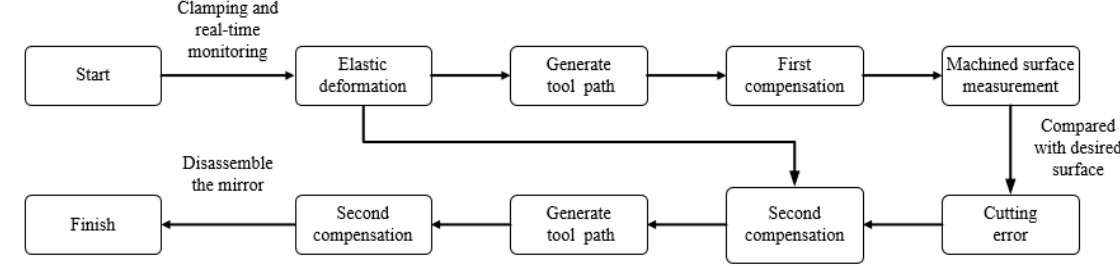
Figure 7. Flow chart of the error compensation experiment.